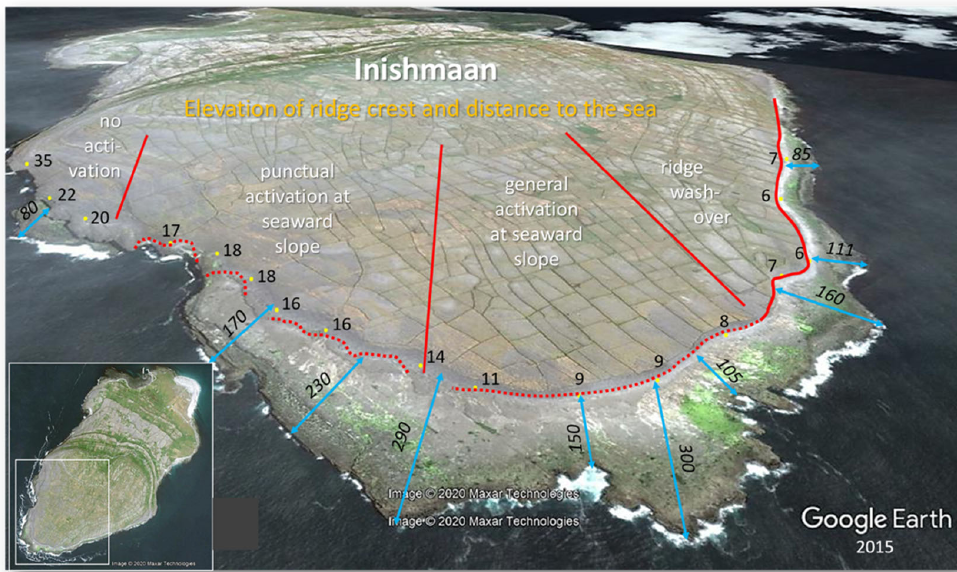
Figure 11. “Envelope“ of strongest storms on registration (hurricanes of winter 2013/2014) at the highest Holocene sea level along the southwest coast of Inishmaan, marked in boulder deposits emplaced during past extreme events from a significant lower sea level.